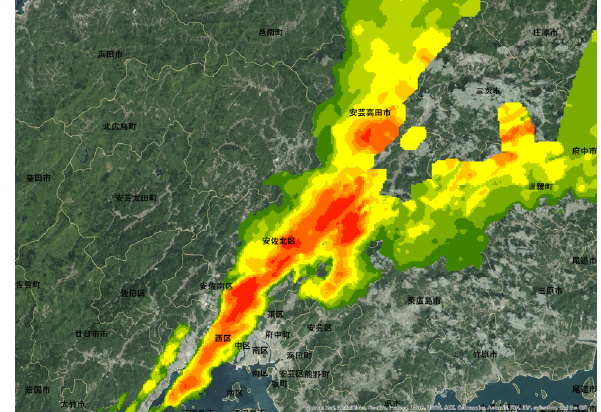
Figure 6. Conversion result of the rainfall data measured by the X-band MP radar (2014.08.20 01:00).